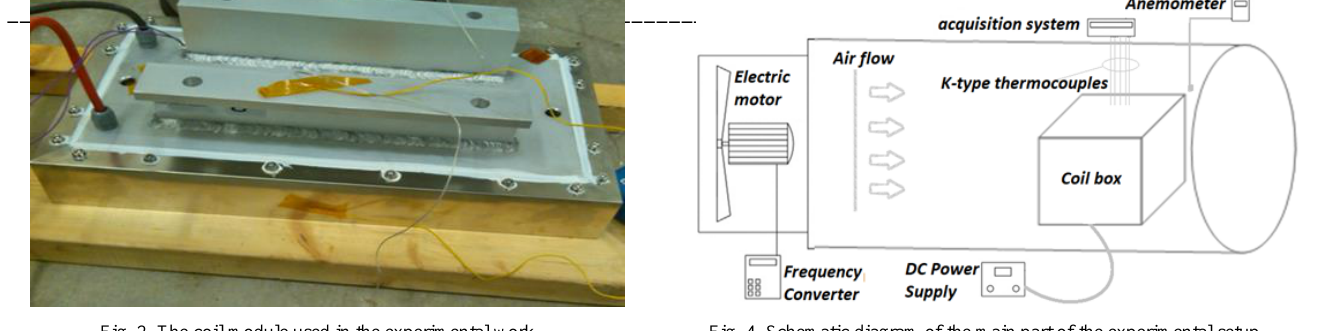
Fig. 2. The coil module used in the experimental work.